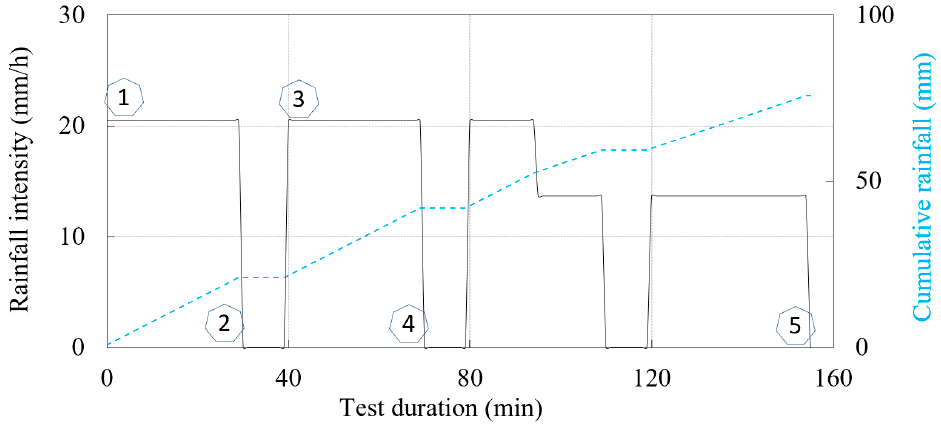
Figure 10. Simulated rainfall in the test considered in Example 2.